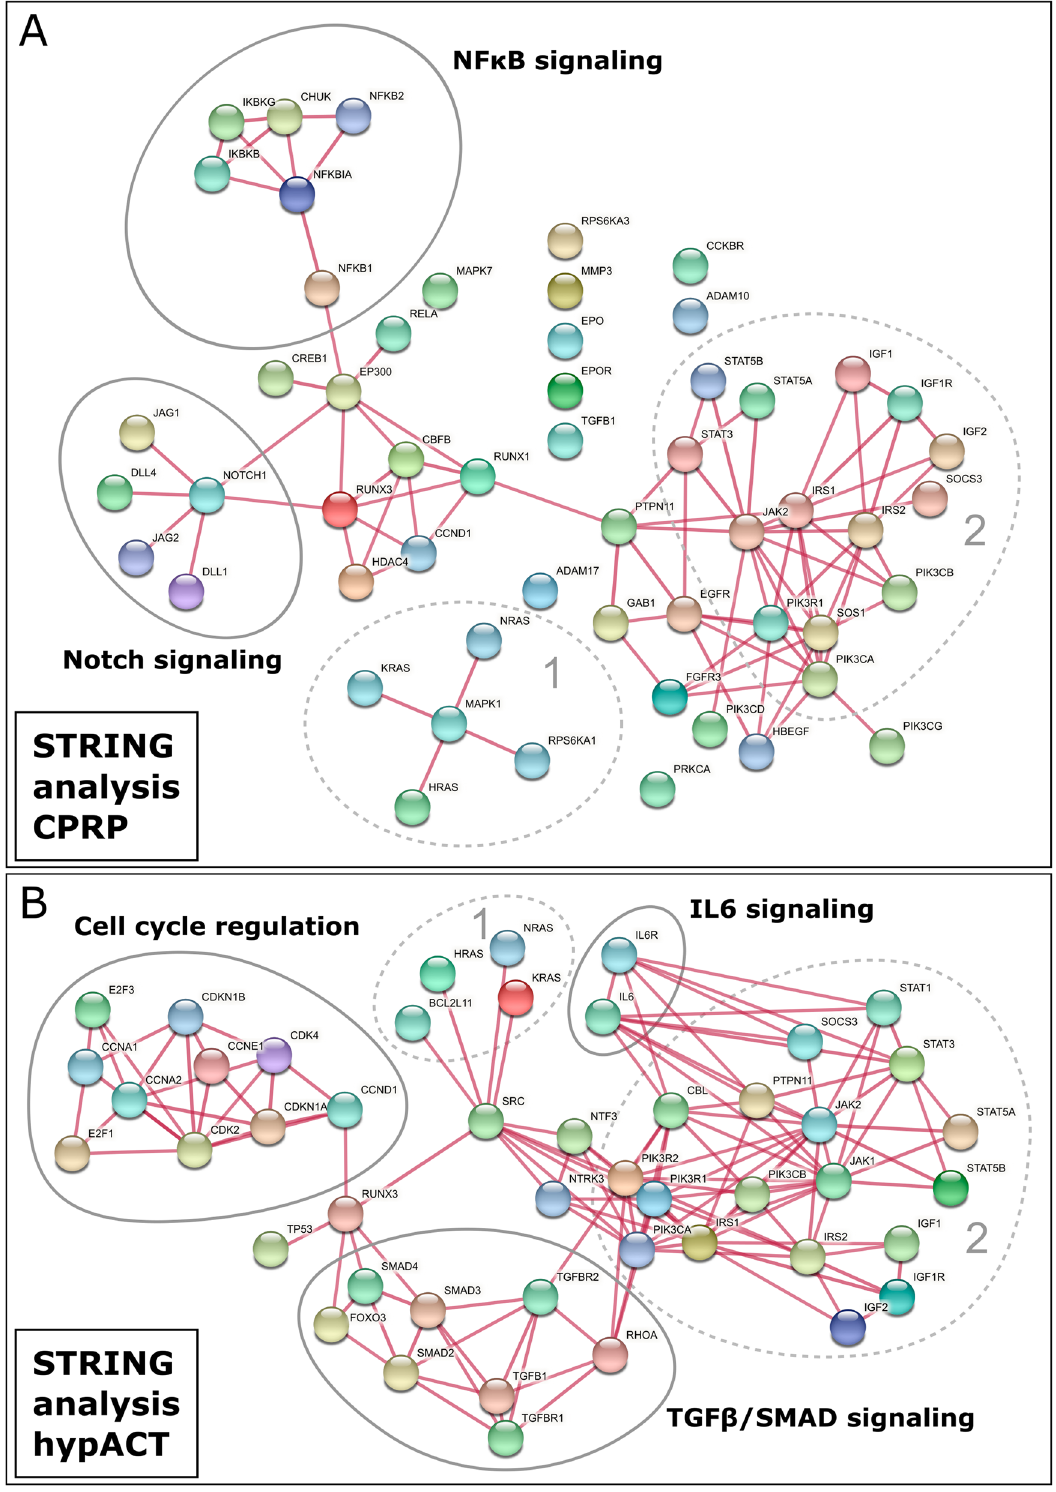
Figure 5. Physical STRING networks of miRNA targets in high confidence Reactome pathways for CPRP and hypACT EVs. Clusters 1 and 2 are found among miRNA targets for EVs from either blood product. ( A ) NFκB and Notch signaling are specifically targeted by CPRP EVs, while ( B ) TGFβ/SMAD signaling, IL6 signaling and cell cycle regulation are high confidence targets of hypACT EVs. Line thickness represents > 0.9 confidence of